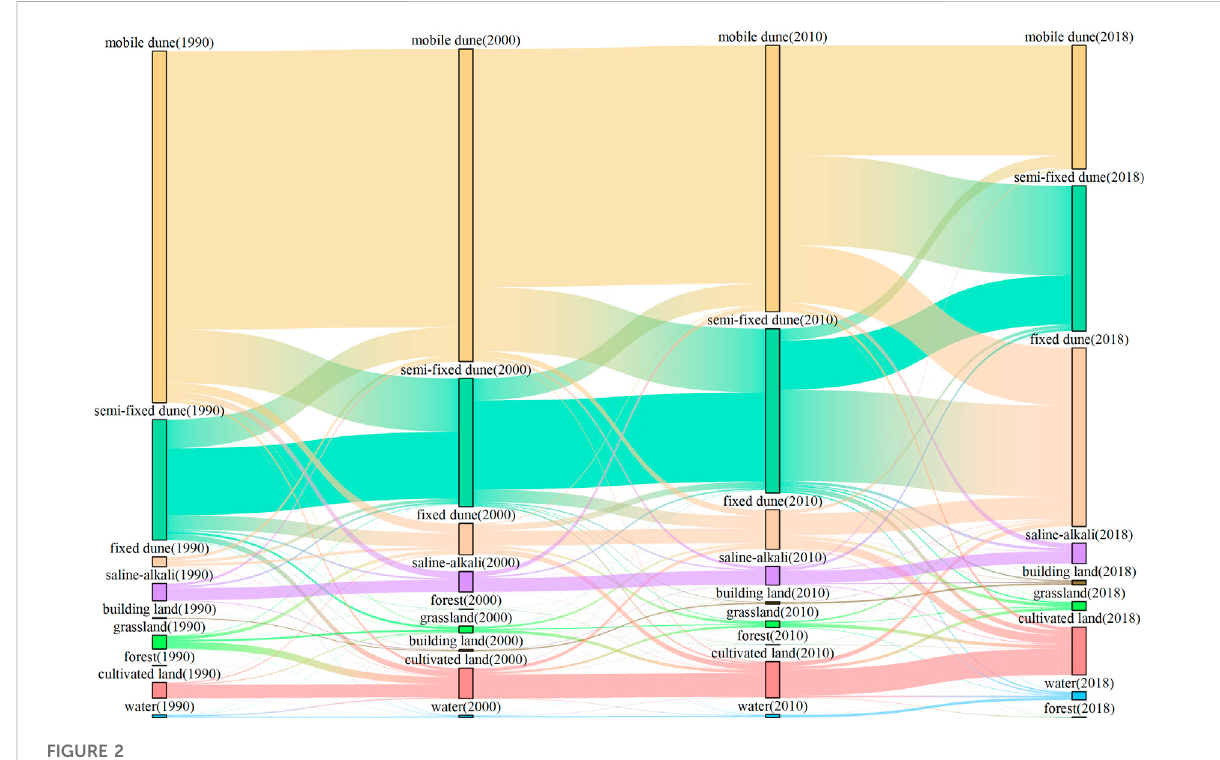
FIGURE 2 Land use dynamics of the Ulan Buh Desert in 1990 – 2018.